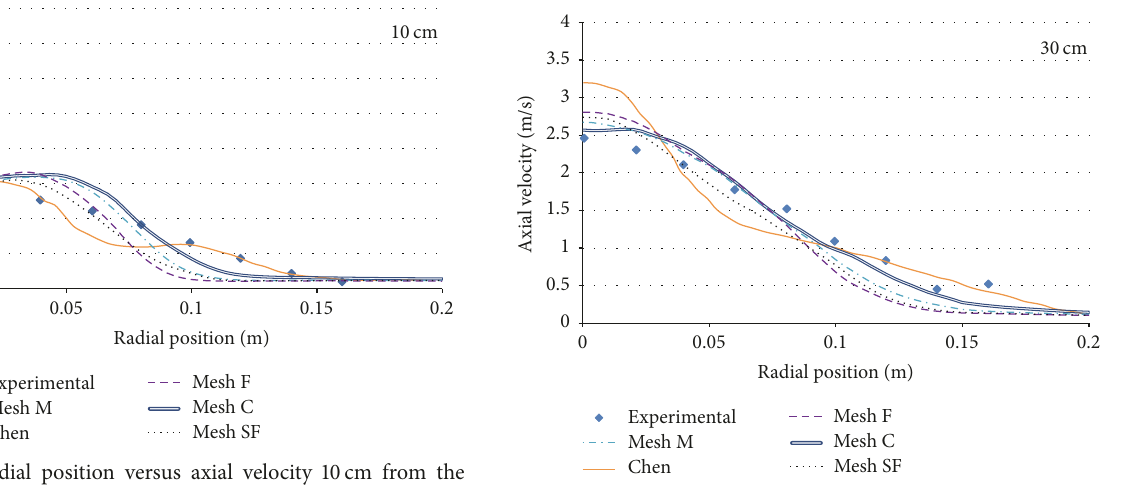
Figure 14: Radial position versus axial velocity 30 cm from the burner